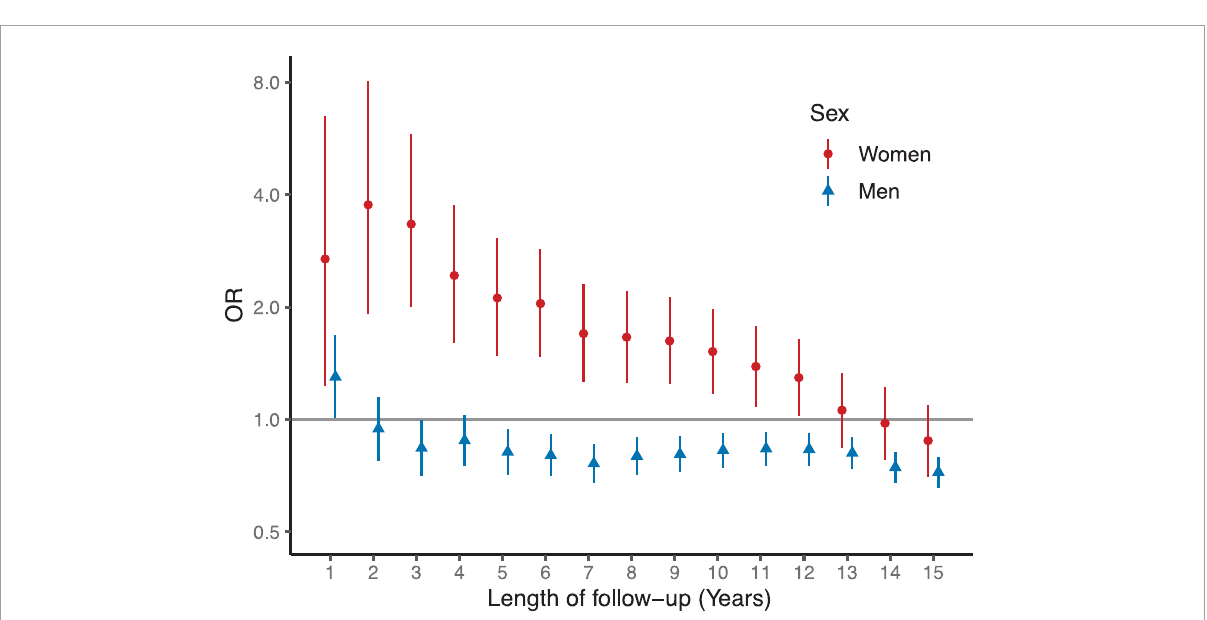
FIGURE2 Odds ratios for death by sex after coronary artery bypass grafting (CABG). Logistic regression models are matched and adjusted for age, BMI and smoking status. Women had increased OR for any death for 12 years after CABG compared to matched and risk adjusted women. In contrast, men had similar or moderately reduced risk for any death than the men in the matched and risk adjusted control